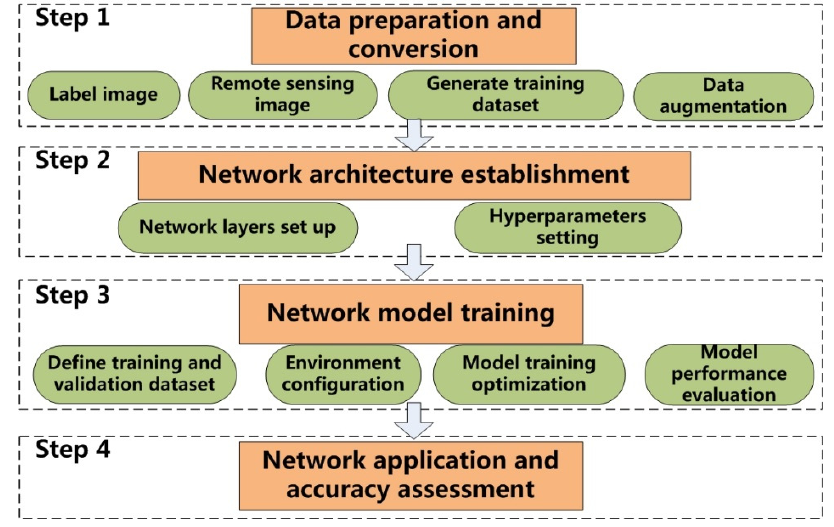
Figure 4. Procedure of the deep neural network training and application.